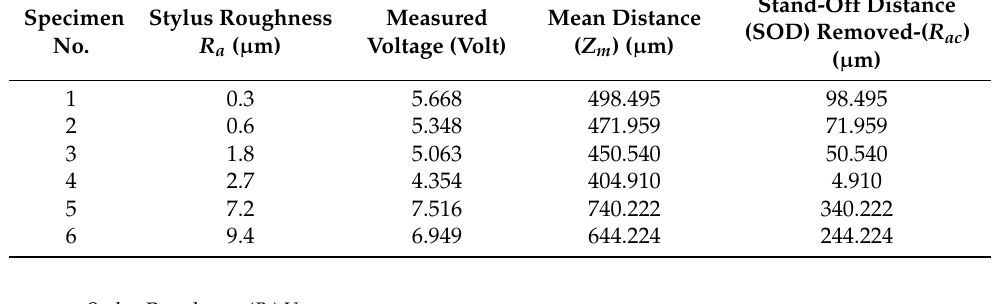
Table 3. Experiment on calibration of sensor against selected specimens to obtain estimation model.